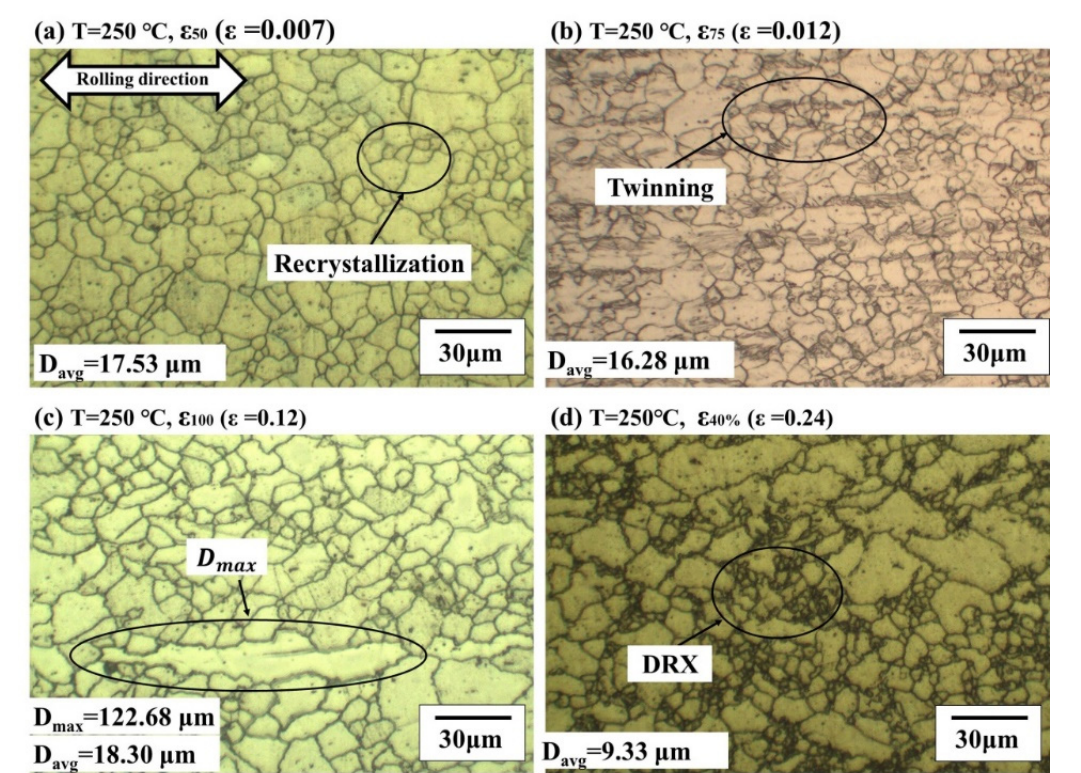
Figure 9. The microstructure of AZ31B after tensile tests at 250 ◦ C with different pre-strains of ( a ) ε 50 ( ε = 0.007), ( b ) ε 75 ( ε = 0.012), ( c ) ε 100 ( ε = 0.12), and ( d ) ε 40% ( ε = 0.24)